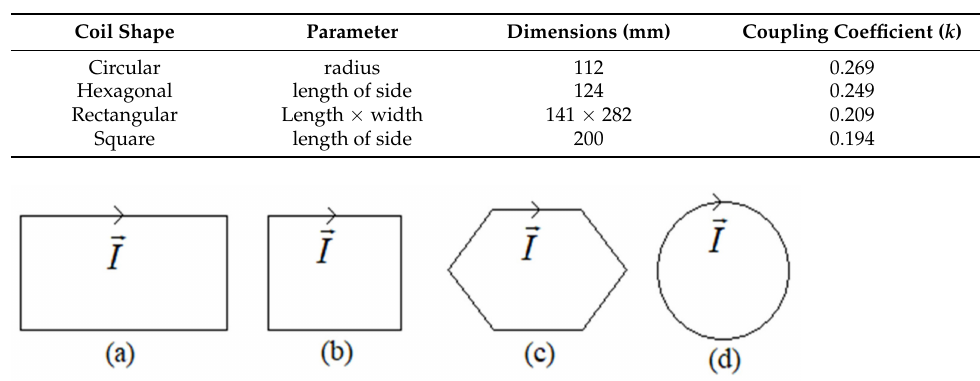
Table 1. Coil specifications and results.